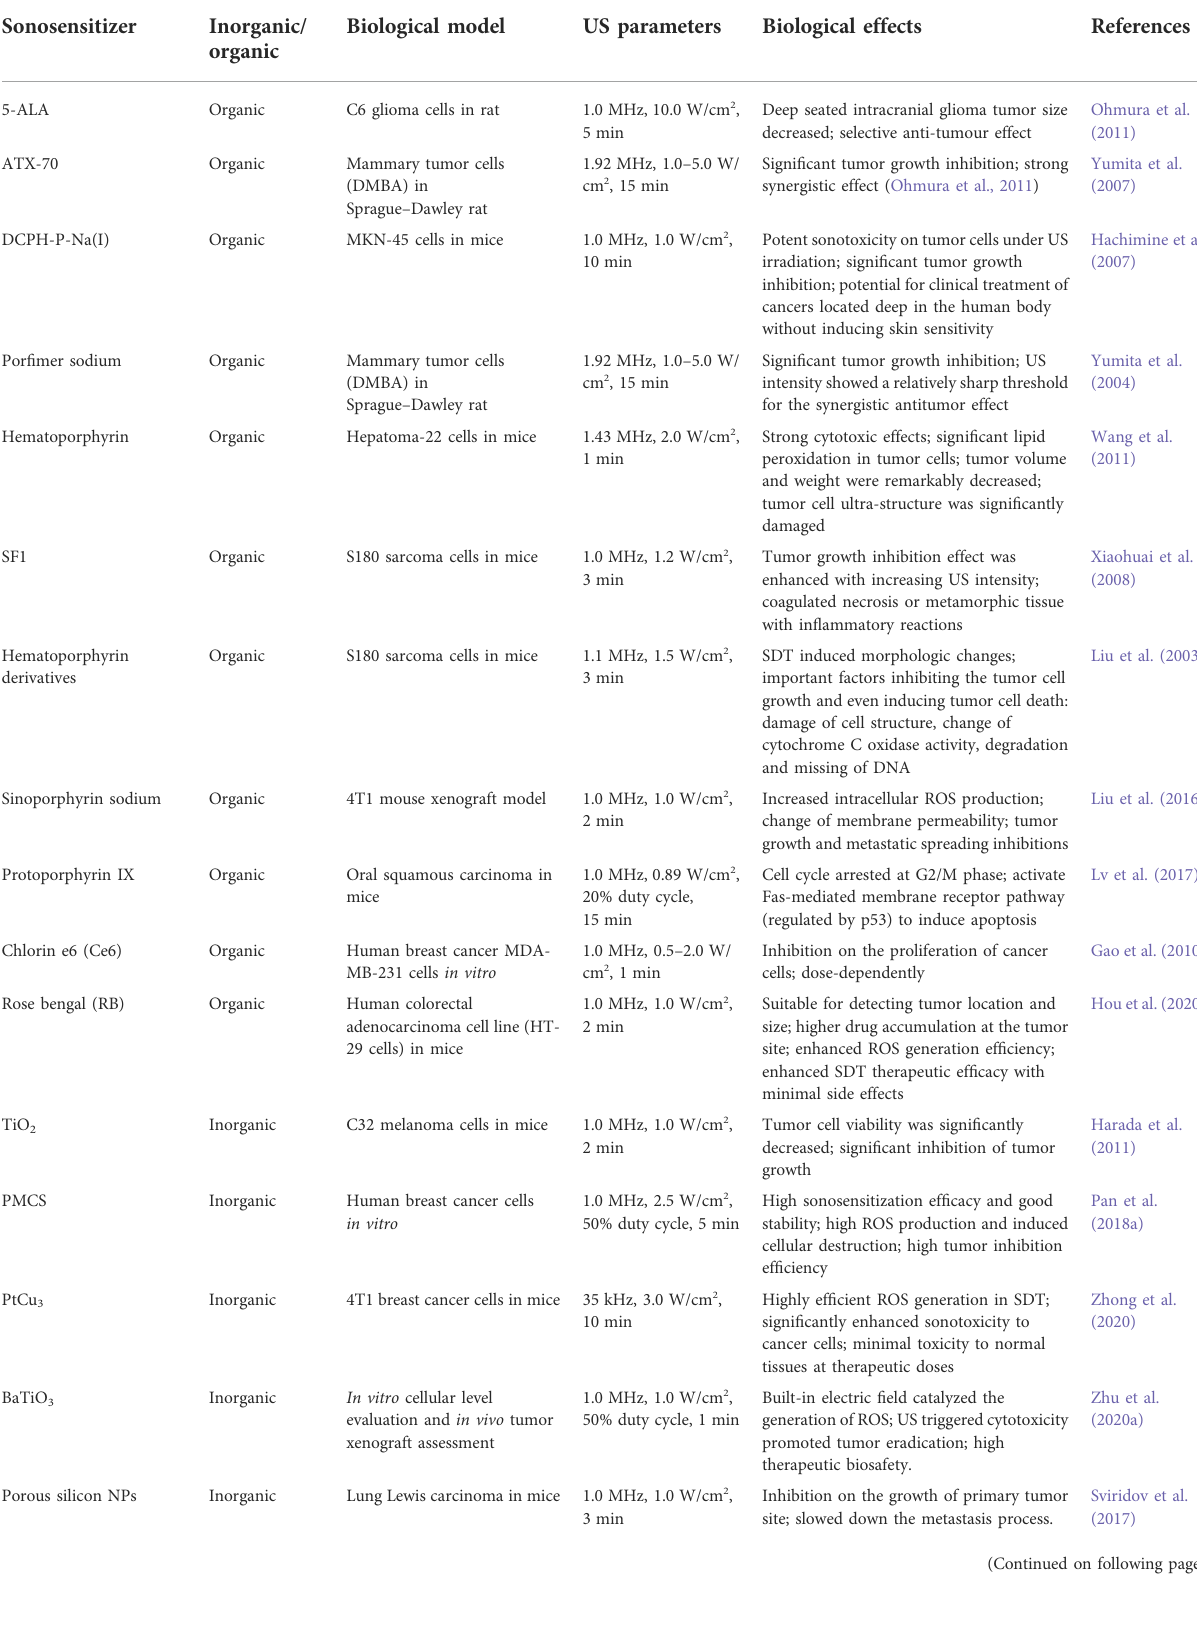
TABLE 1 Summary of sonosensitizers and SDT